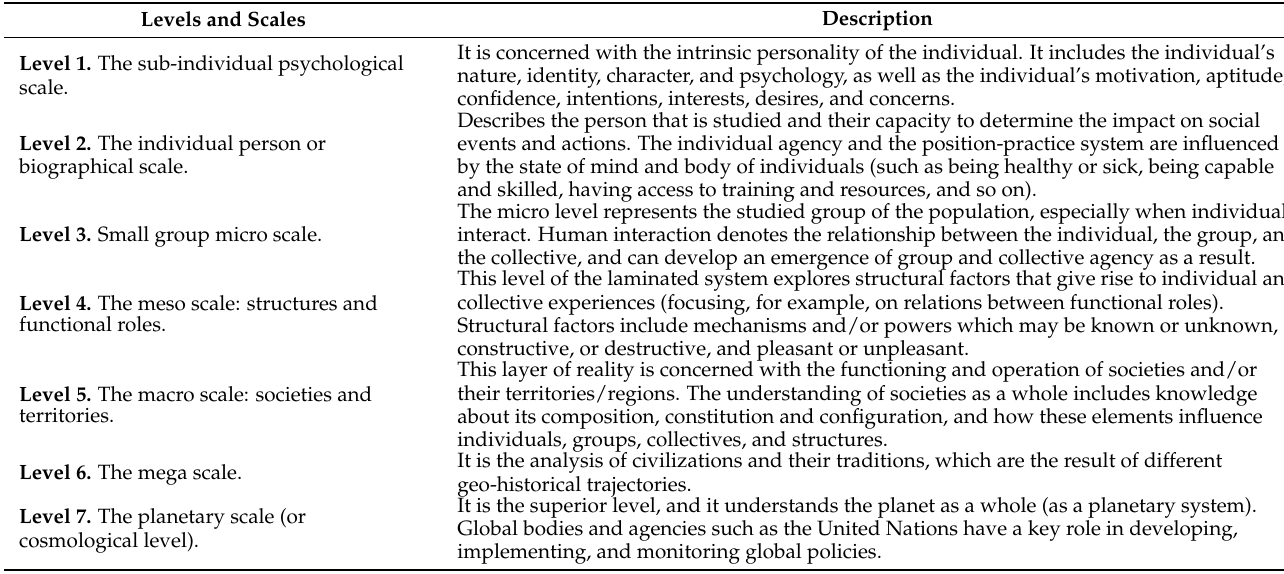
Table 2. The seven-scalar laminated